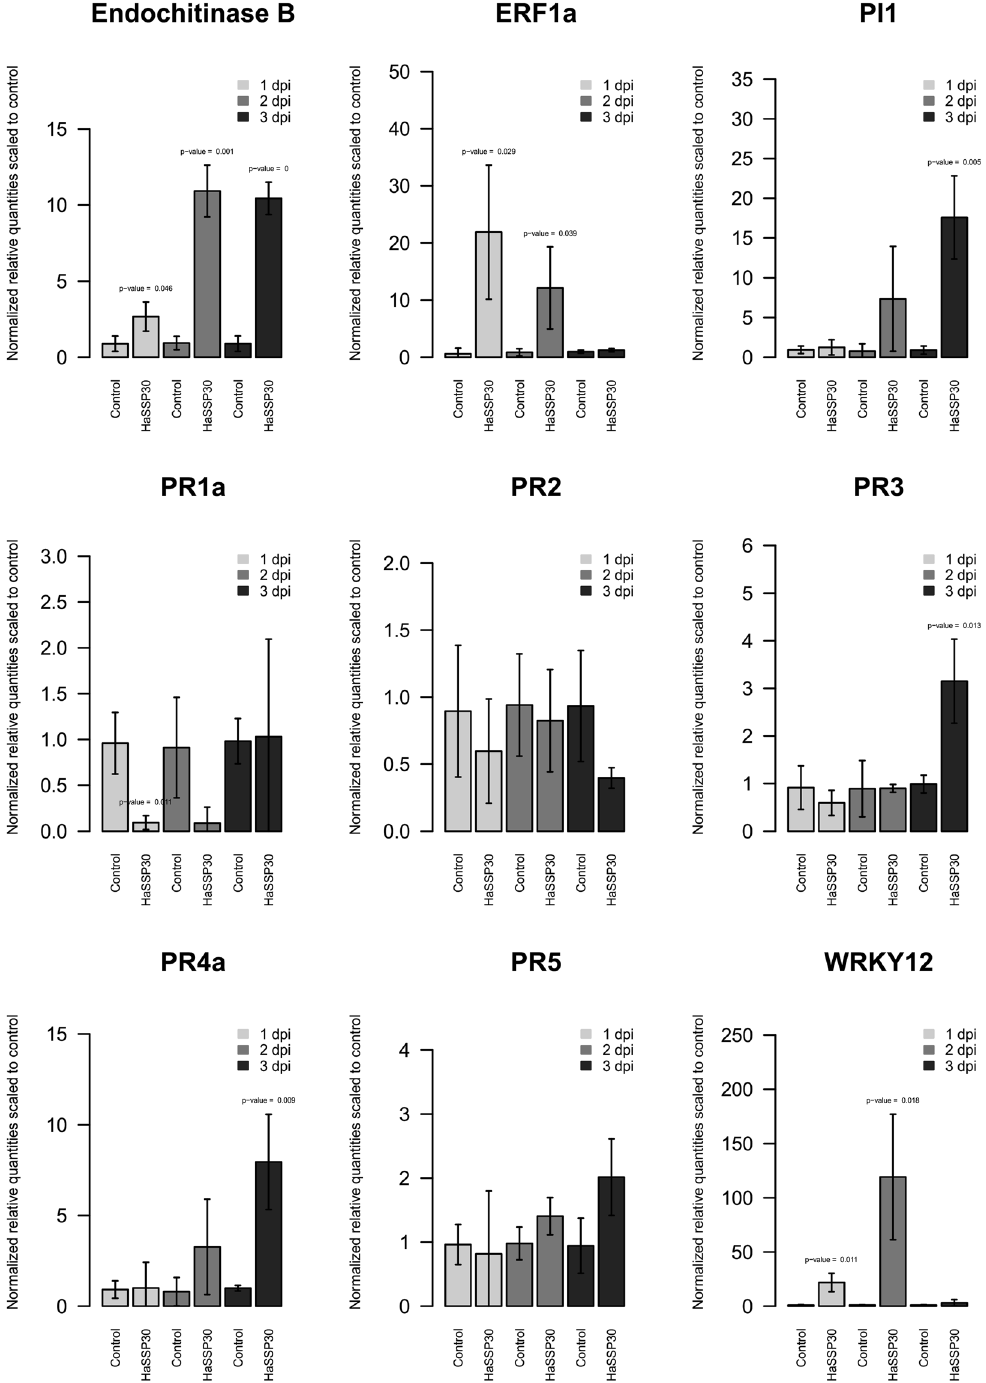
Figure 4. Gene expression levels of several markers related to plant immunity in Nicotiana benthamiana leaves transiently expressing HaSSP30 for 1, 2, and 3 days. Nicotiana benthamiana leaves were infiltrated with Agrobacterium tumefaciens GV3101 carrying either the pICH86988-empty (Control) or pICH86988-HaSSP30 (HaSSP30) vector. The plants were incubated in a plant growth room with 12 h/12 h, night/day photoperiods at 20–24 °C with 60% relative humidity (RH). The leaves were harvested after 1, 2, and 3 days post-infiltration (dpi). Total RNA was extracted and reverse transcribed into cDNA. The qPCR was performed on the cDNA using specific primers for several genes related to activation of plant immunity. Two reference genes were used to normalize the data, which are presented as normalized relative quantities scaled to control. Error bars indicated the standard deviation (SD) of 3 independent replicates (n = 3). Two-tailed Student t-test was used to compare HaSSP30 versus Control in each day and p-values < 0.05 are indicated above the